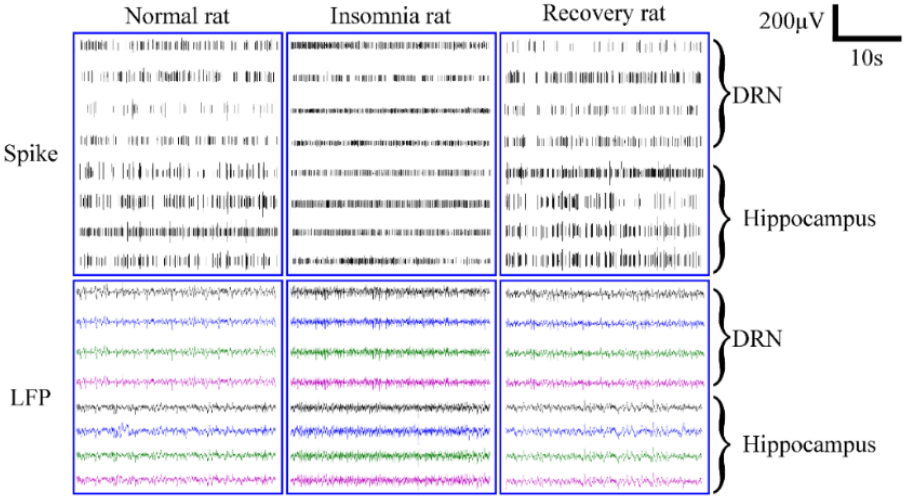
Figure 6. Captures of neural spiking activity (upper panel) and local field potentials (LFPs) (lower panel) across eight channels of rats in normal, insomnia, and recovery states.